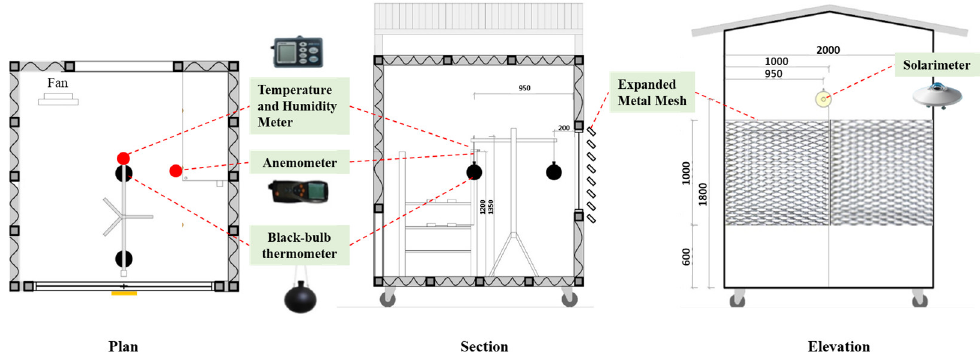
Figure 5. Measurement configuration of indoor temperature experiment.